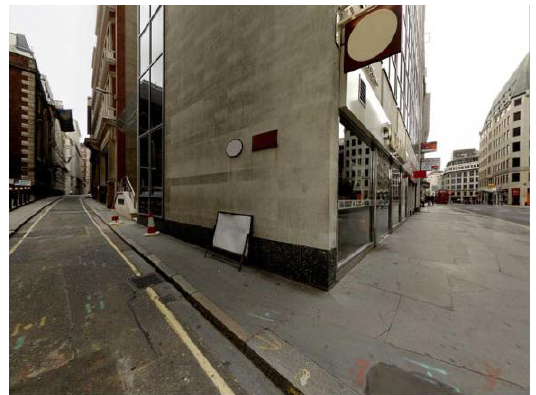
Figure 1. Example